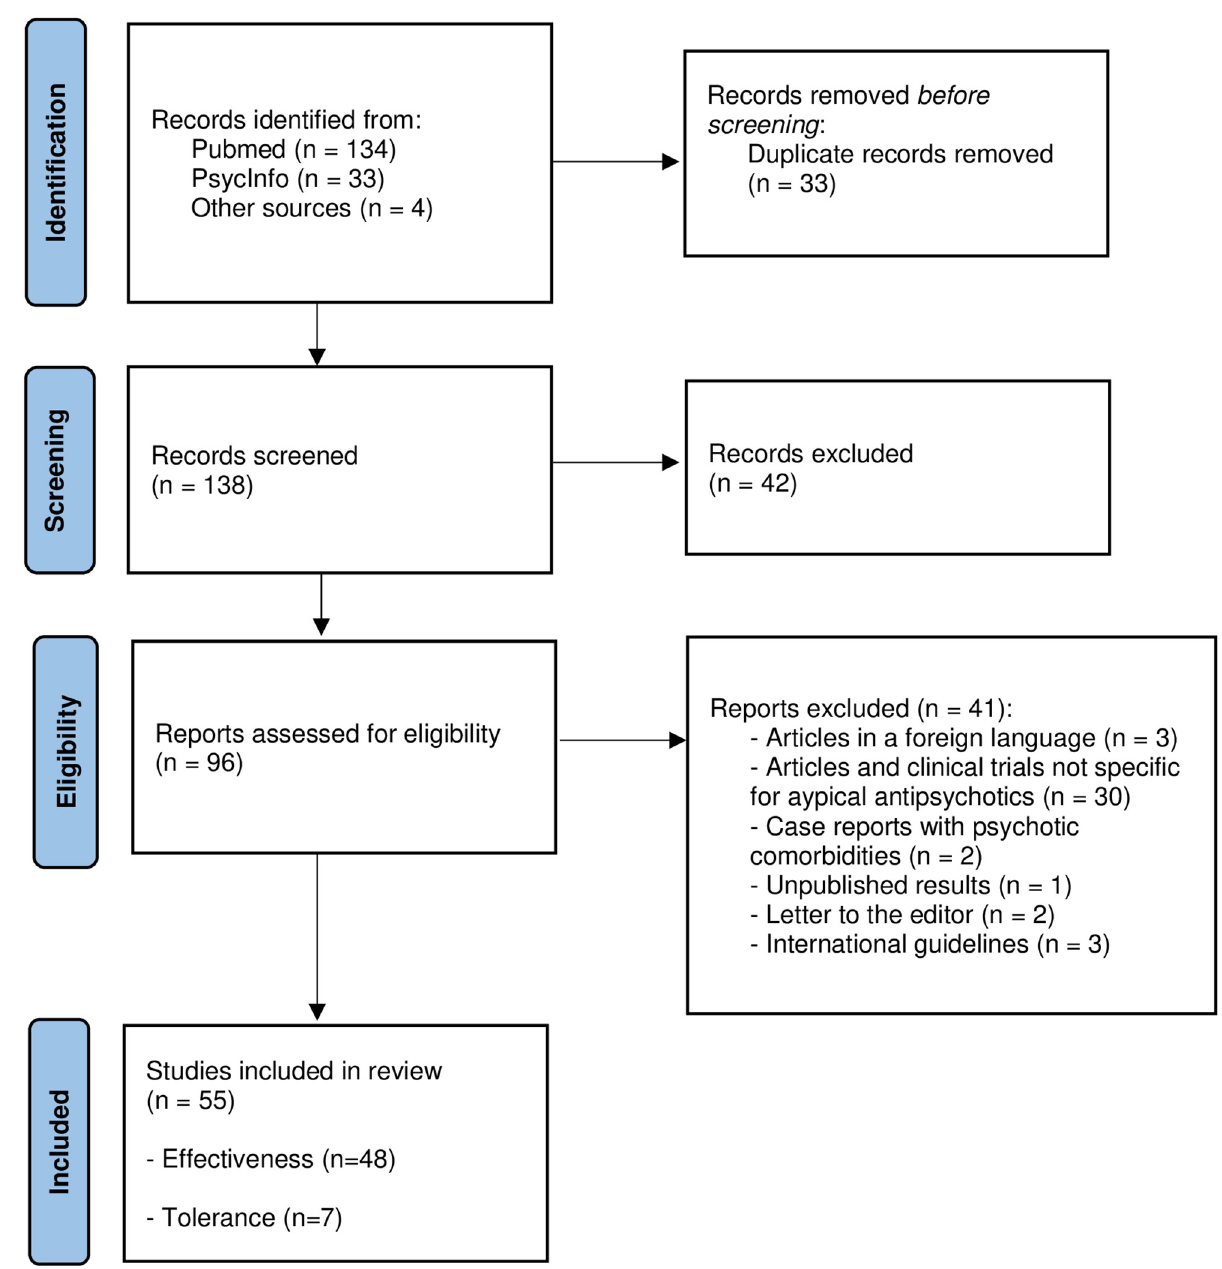
Fig 1. PRISMA 2020 flow chart of the systematic scoping